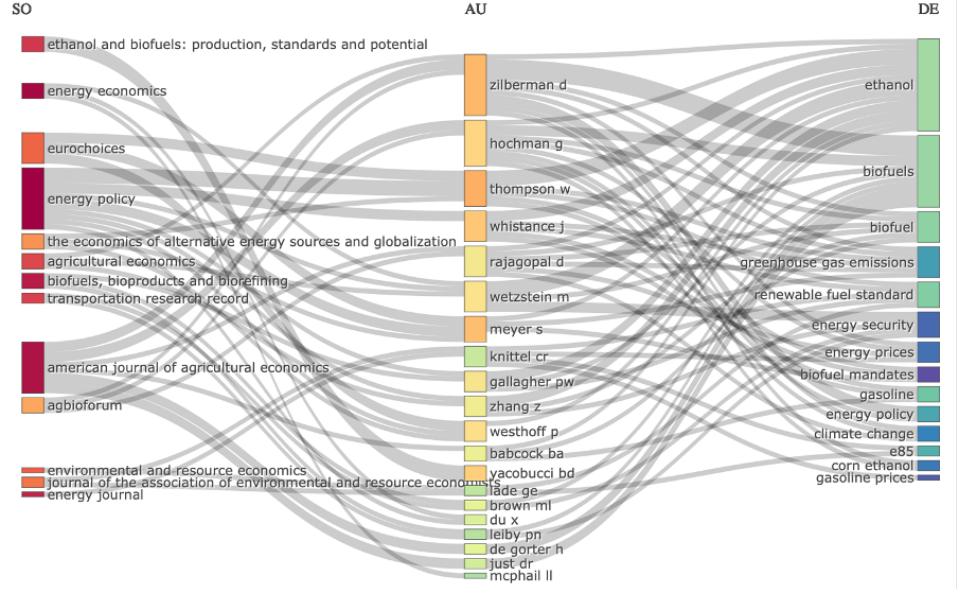
Figure 9. Tree-Field plot (Authors × sources × keywords).